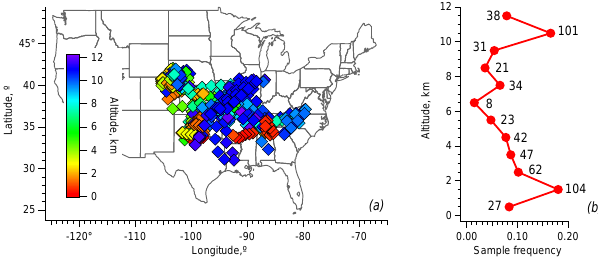
Figure 1. (a) Filter collection sampling locations, color-coded by altitude, and (b) sampling frequency versus altitude for the complete DC3 mission, with number of filters for each altitude bin